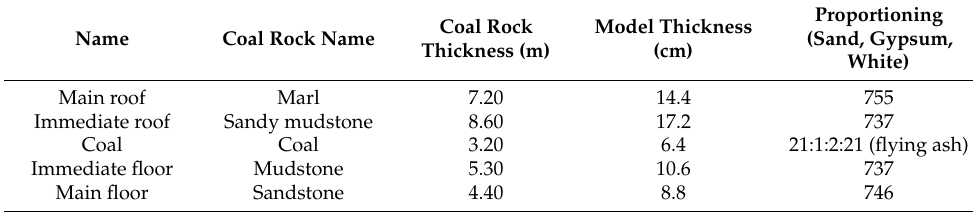
Table 2. The proportion of similar